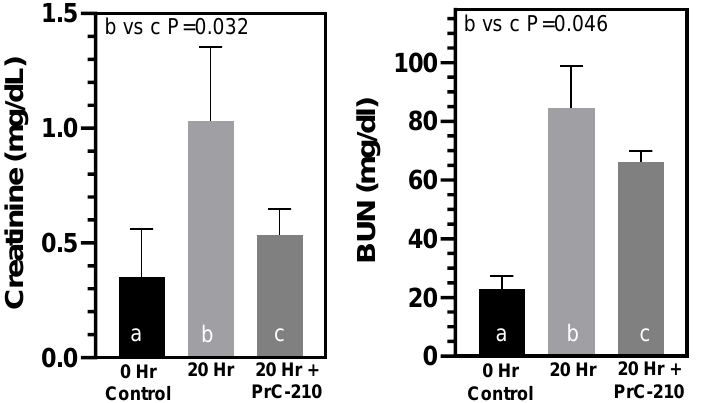
Figure 4. Effects of PrC-210 administration on kidney function 20 h after transplant of the BN kidney into a LEW rat. Rats either received no PrC-210 (“20 h”) or three IP PrC-210 injections in the 20 h period following transplant (“20 h + PrC-210”), before recipient rat was euthanized and serum was collected. Serum BUN and creatinine levels were determined as described in Methods. p values are indicated. a,b,c designations are used to enable statistical comparisons between groups.